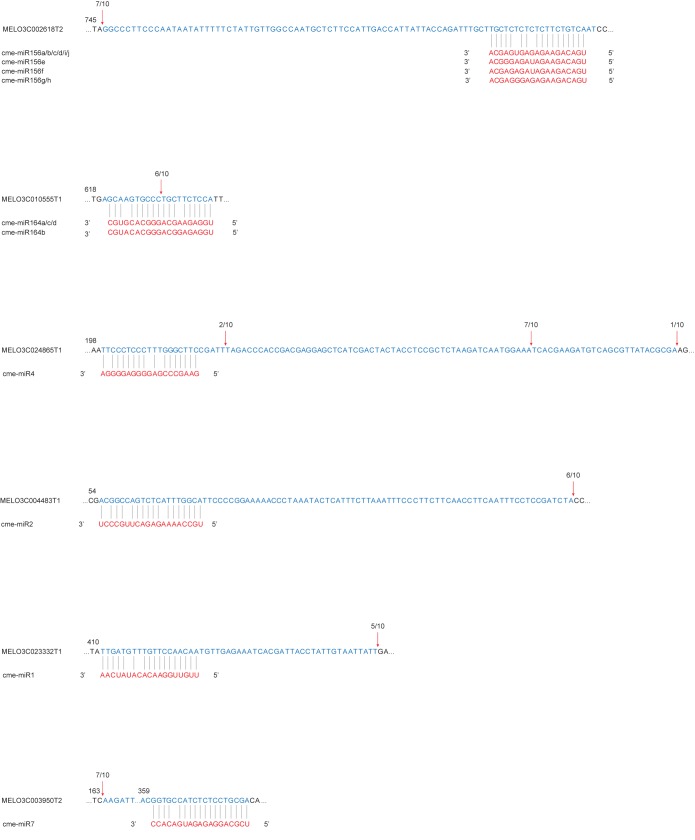
Verification of miRNA-guided mRNA cleavage using 5’ RACE.Partial sequences from target genes were aligned with the corresponding miRNAs. Each top strand (blue) represents a miRNA-homologous site in the target gene and each bottom strand (red) represents the aligned sequence of miRNA. Red arrows indicate the observed miRNA cleavage sites following 5’ RACE analysis, with the frequency of clones shown.